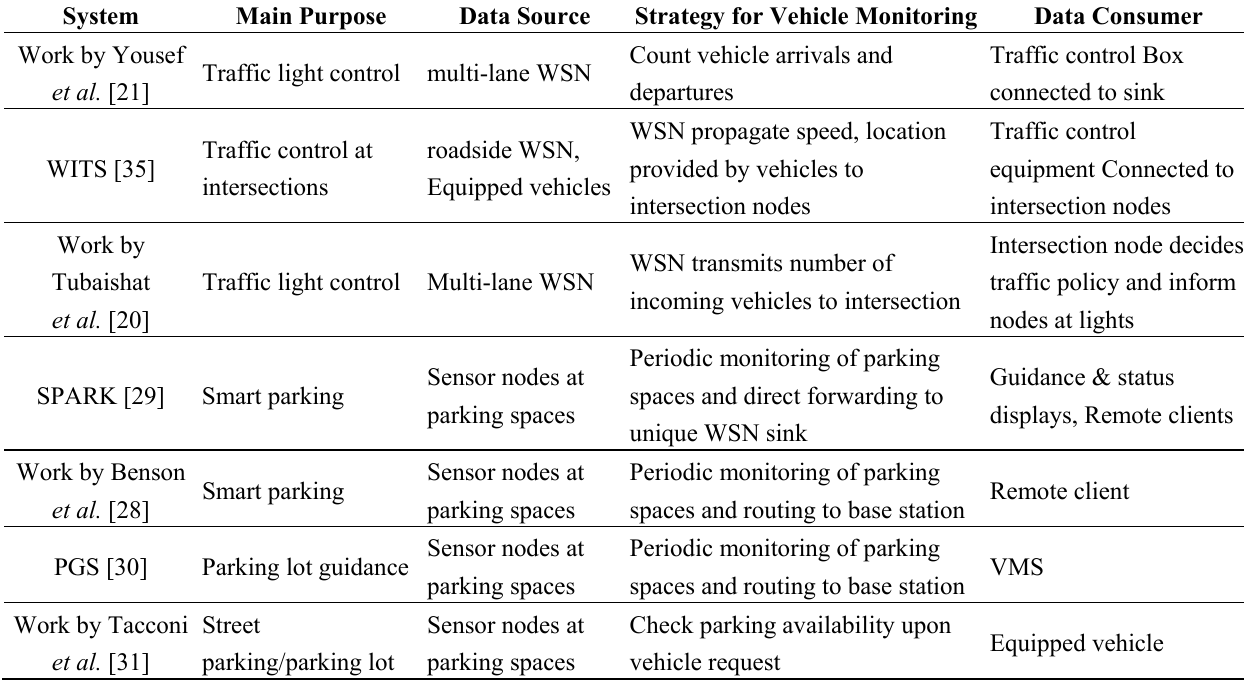
Table 2. Functional description of selected WSN-based ITS traffic control & smart parking applications.